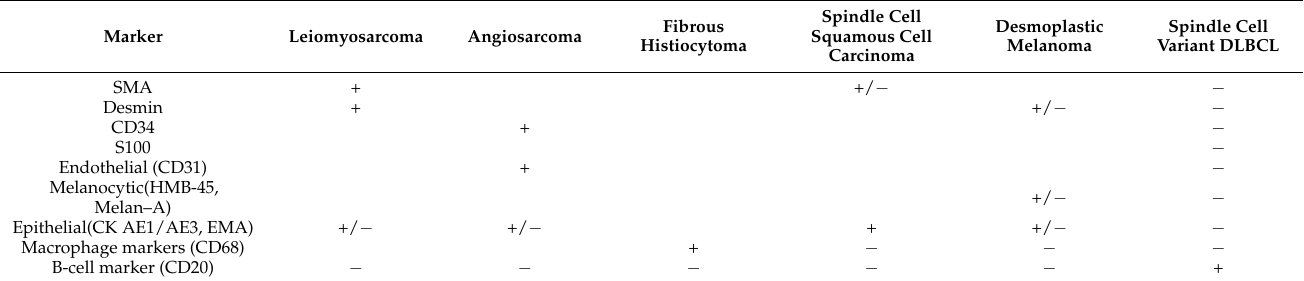
Table 1. Differential